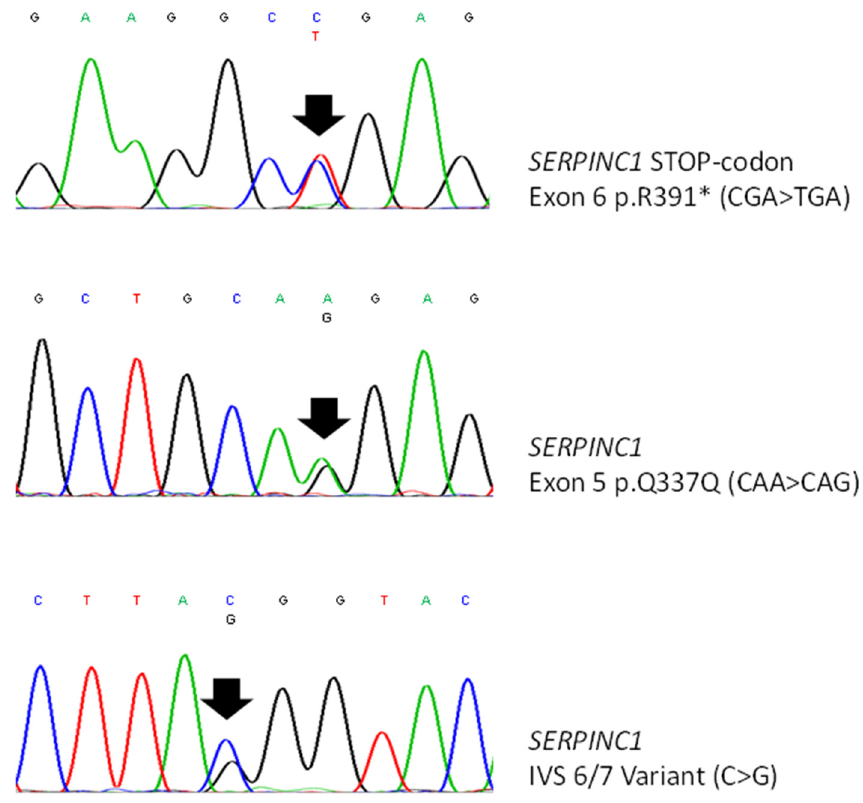
Figure 2. Sequence analysis of SERPINC1 gene showing: p.R391* STOP-codon (upper panel); p.Q337Q synonymous variant (middle panel); intronic (IVS 6–7) C > G variant (rs677) (lower